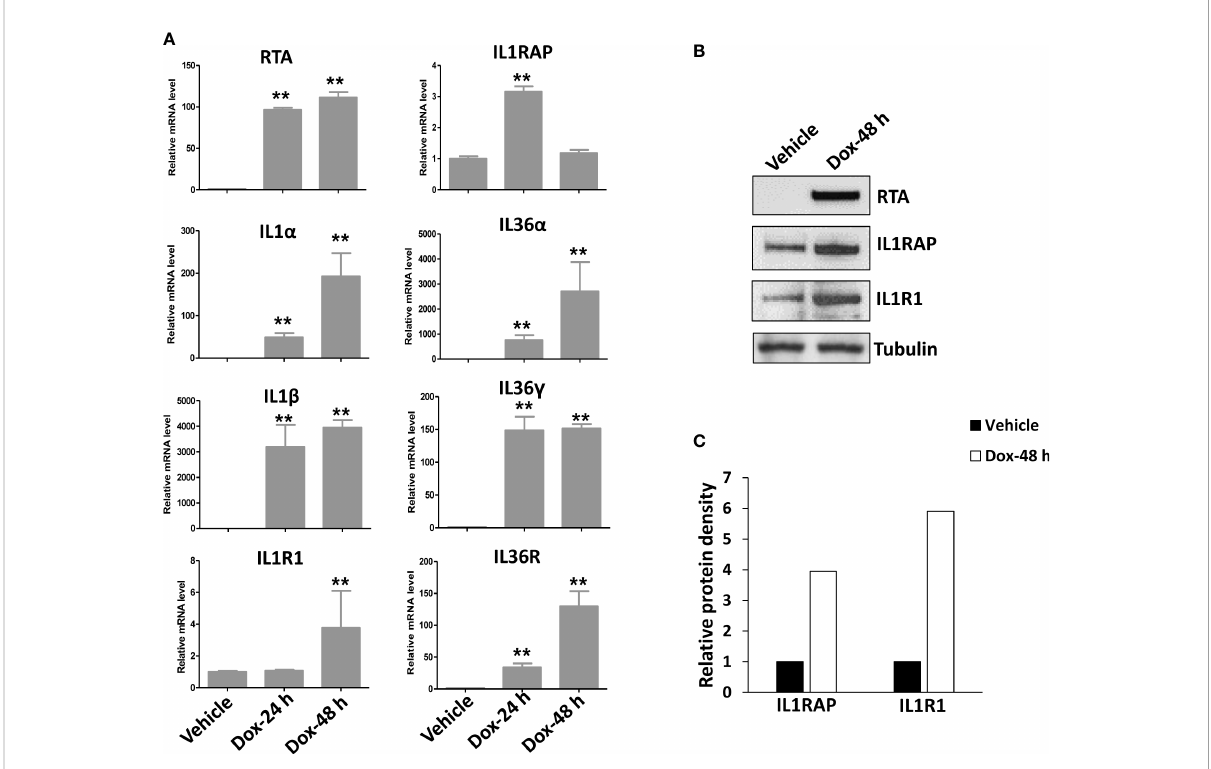
FIGURE 2 Further activation of IL1 signaling during KSHV lytic reactivation. The TREx BCBL1-Rta cell line was induced to lytic reactivation after exposure to 1 m g/ mL of doxycycline (Dox) for 24 or 48 h, respectively. (A) Gene expression was then detected and compared by using RT-qPCR. RTA represents a key viral gene controlling KSHV “ latency to lytic ” switch. Error bars represent the S.D. for 3 independent experiments. **p<0.01. (B, C) The protein expression was measured using Western blot, and representative blots from one of two independent experiments were shown. The density of protein bands was scanned and quanti fi ed using Image J